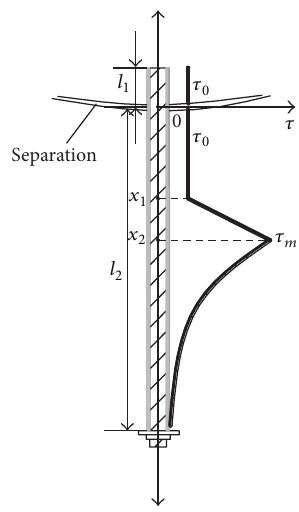
Figure 5: Shear stress distribution of the damaged interface when separation occurs at the free loading